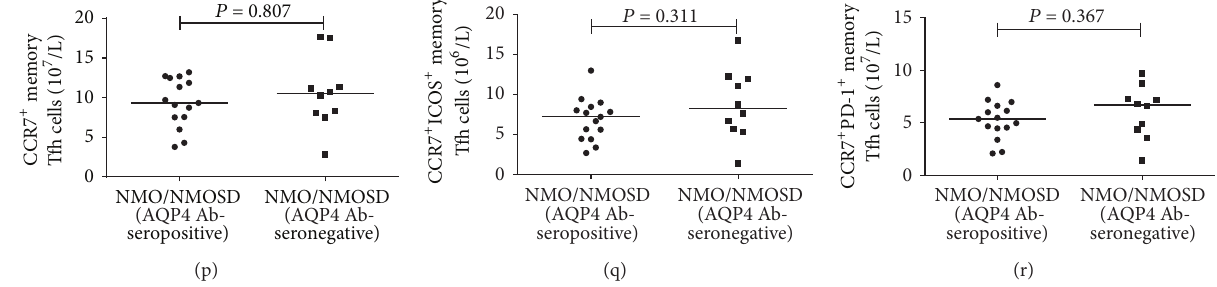
Figure 2: Analysis of the percentages and numbers of different subsets of memory Tfh, CCR7 − memory Tfh, and CCR7 + memory Tfh cells in AQP4 Ab-seropositive and AQP4 Ab-seronegative patients. ((a)–(c)) The percentages of memory Tfh, ICOS + memory Tfh, and PD-1 + memory Tfh cells in AQP4 Ab-seropositive and AQP4 Ab-seronegative patients. ((d)–(f)) The numbers of memory Tfh, ICOS + memory Tfh, and PD-1 + memory Tfh cells in AQP4 Ab-seropositive and AQP4 Ab-seronegative patients. ((g)–(i)) The percentages of CCR7 − , CCR7 − ICOS + , and CCR7 − PD-1 + memory Tfh cells in AQP4 Ab-seropositive and AQP4 Ab-seronegative patients. ((j)–(l)) The numbers of CCR7 − , CCR7 − ICOS + , and CCR7 − PD-1 + memory Tfh cells in AQP4 Ab-seropositive and AQP4 Ab-seronegative patients. ((m)–(o)) The percentages of CCR7 + , CCR7 + ICOS + , and CCR7 + PD-1 + memory Tfh cells in AQP4 Ab-seropositive and AQP4 Ab-seronegative patients. ((p)–(r)) The numbers of CCR7 + , CCR7 + ICOS + , and CCR7 + PD-1 + memory Tfh cells in AQP4 Ab-seropositive and AQP4 Ab-seronegative